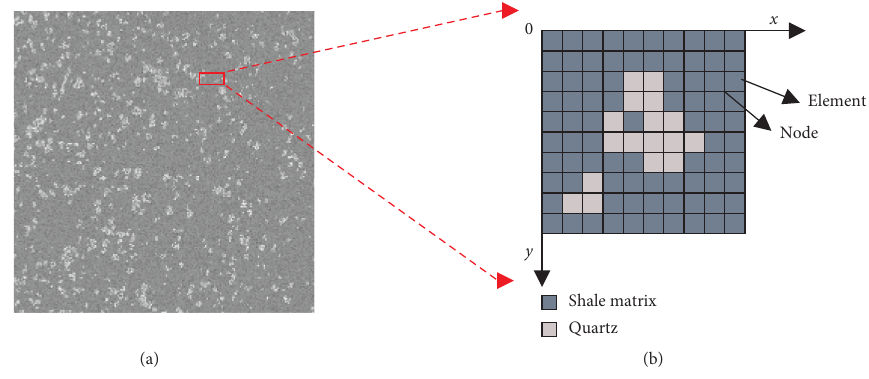
Figure 10: Numerical model and grid after shale